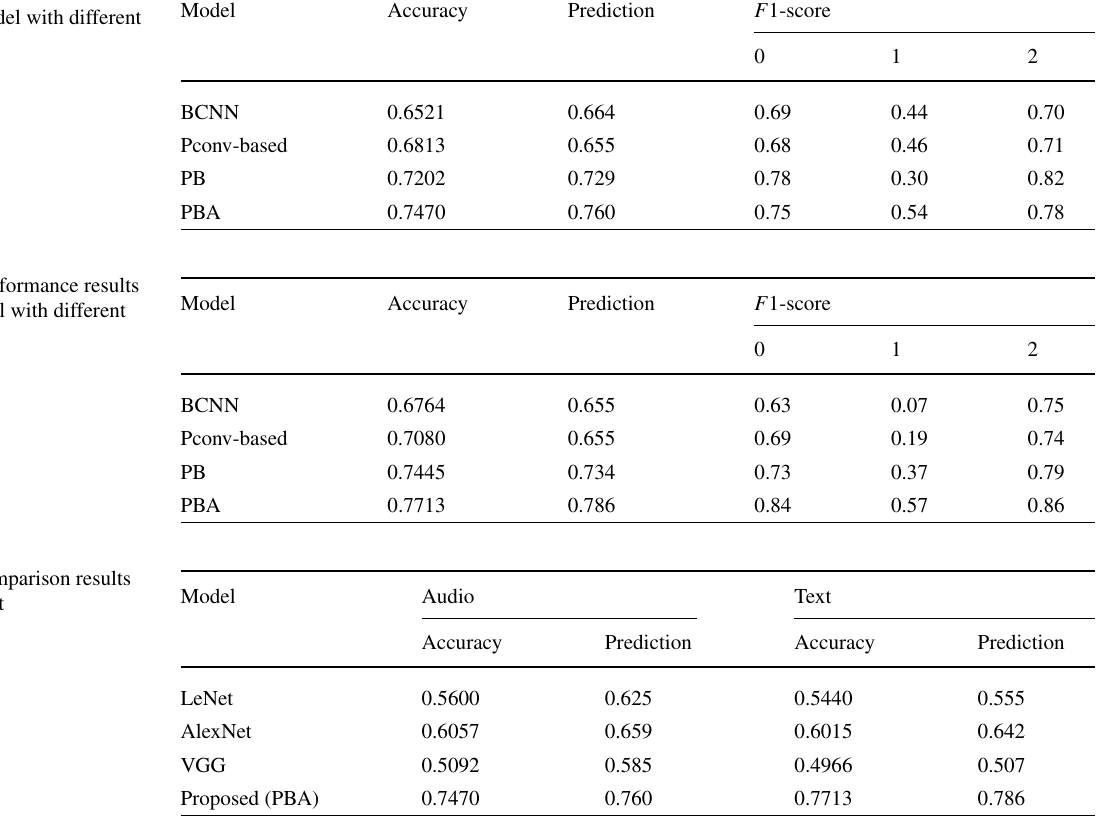
Table 2 The performance results of the audio model with different methods